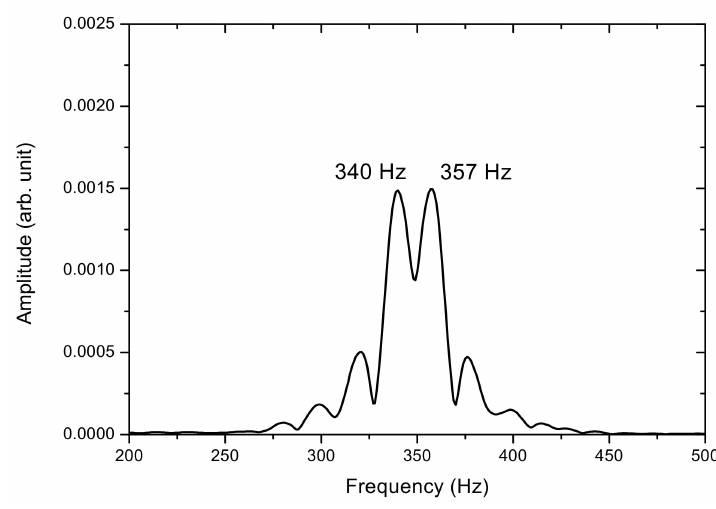
Figure 11. Frequency spectrum of the motion of the vibrating string at 3.9 × 10 − 2 m/s.